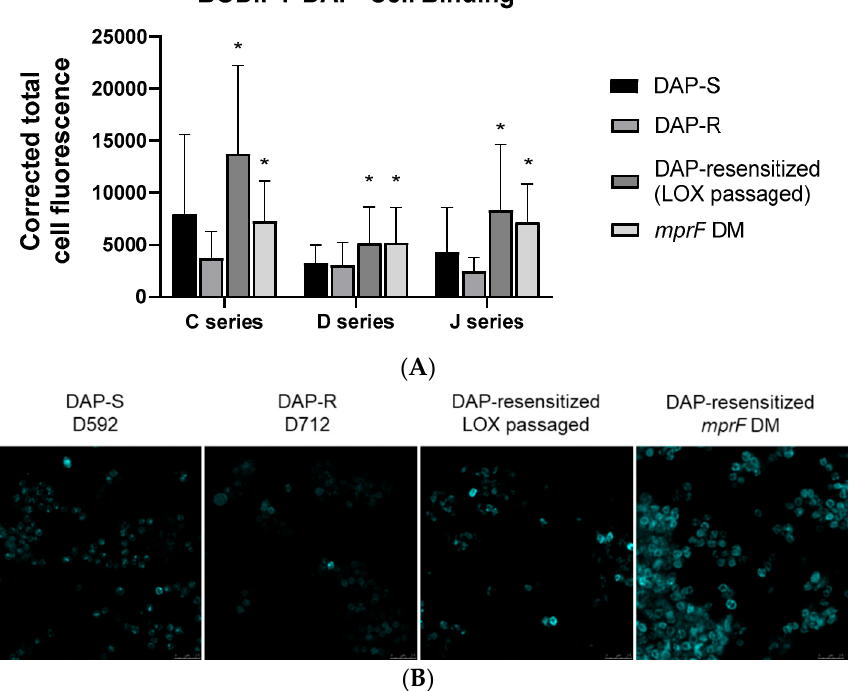
Figure 1. Binding of BODIPY-labeled daptomycin (BODIPY-DAP) to S. aureus study strains. ( A ) Corrected total cell fluoresence of BODIPY-DAP binding. ( B ) Representative confocal microscopy images of BODPY-DAP binding in the well-characterized D series strains. * p < 0.01 vs. DAP R-strain. Table 2. Phospholipid composition (%) of LOX passaged strain vs. DAP-R/DAP-S.